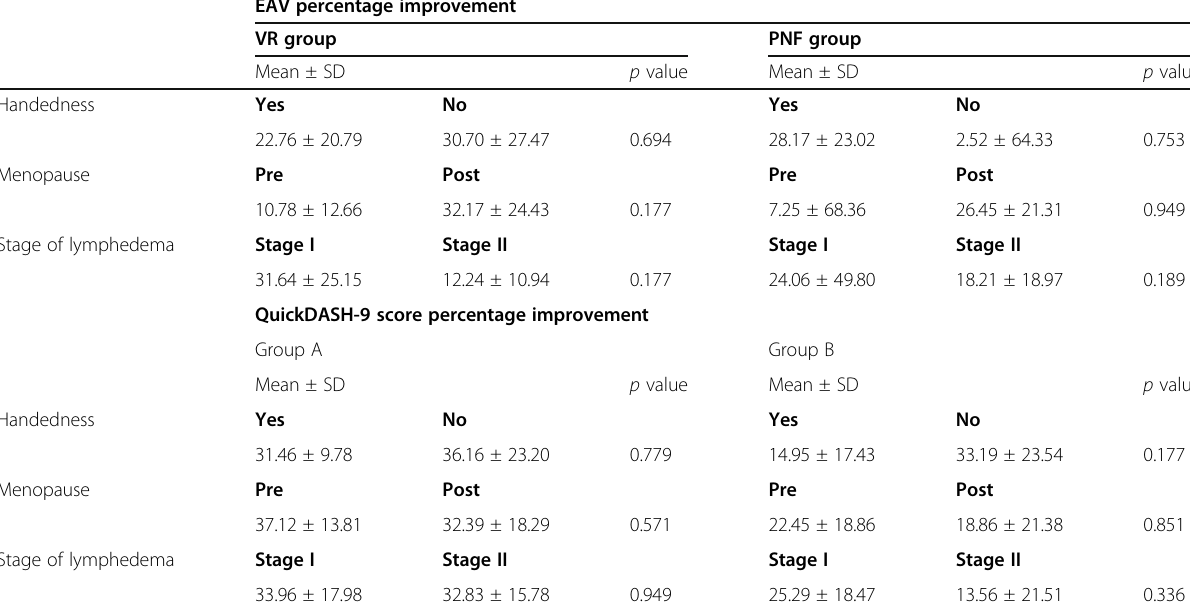
Table 4 Relationship between the EAV percentage improvement and percentage functional improvement and patient handedness, menopausal status, and stage of